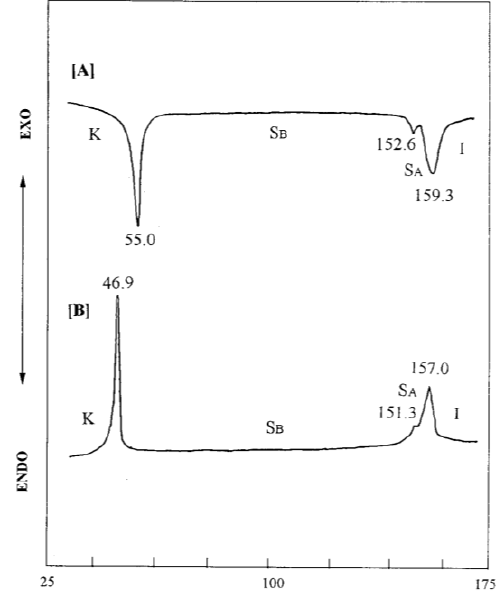
= smectic A; S = smectic A B